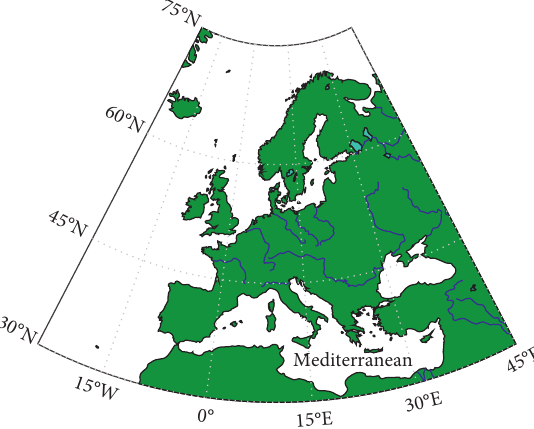
Figure 3: Main distribution areas of herring and